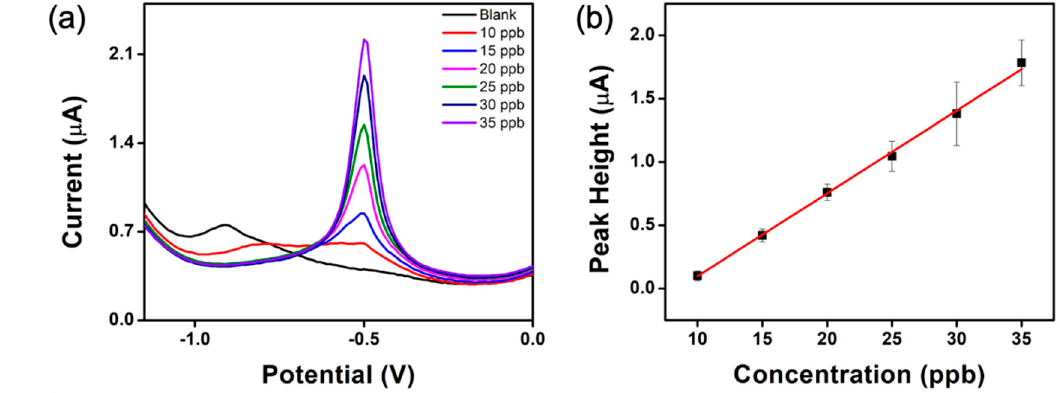
Figure 8. Lead detection using the CNT-NEE. ( a ) SWASV response in 0.1 M acetate buffer (pH 4.5) with varying concentrations Pb 2+ (0, 10, 15, 20, 25, 30, and 35 ppb). ( b ) Calibration curve for Pb 2+ detection (n = 3).